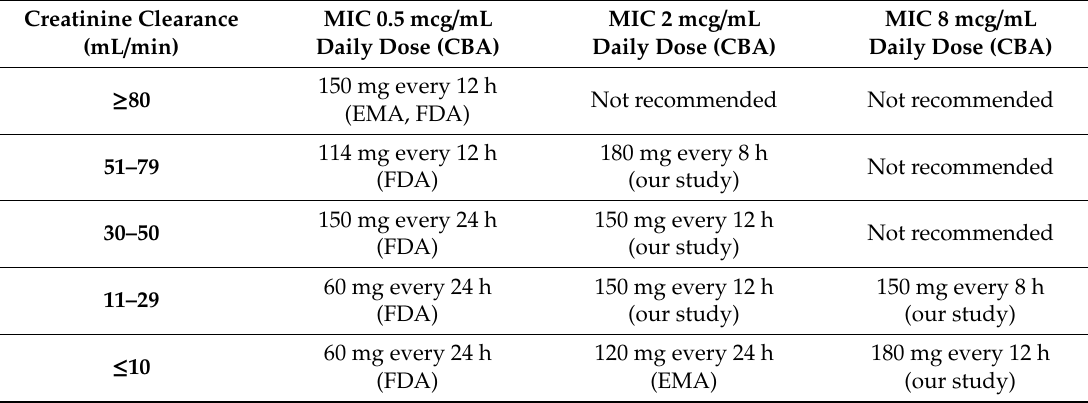
Table 5. The recommended dose based on the ability to achieve PTA target at various MICs. Creatinine Clearance